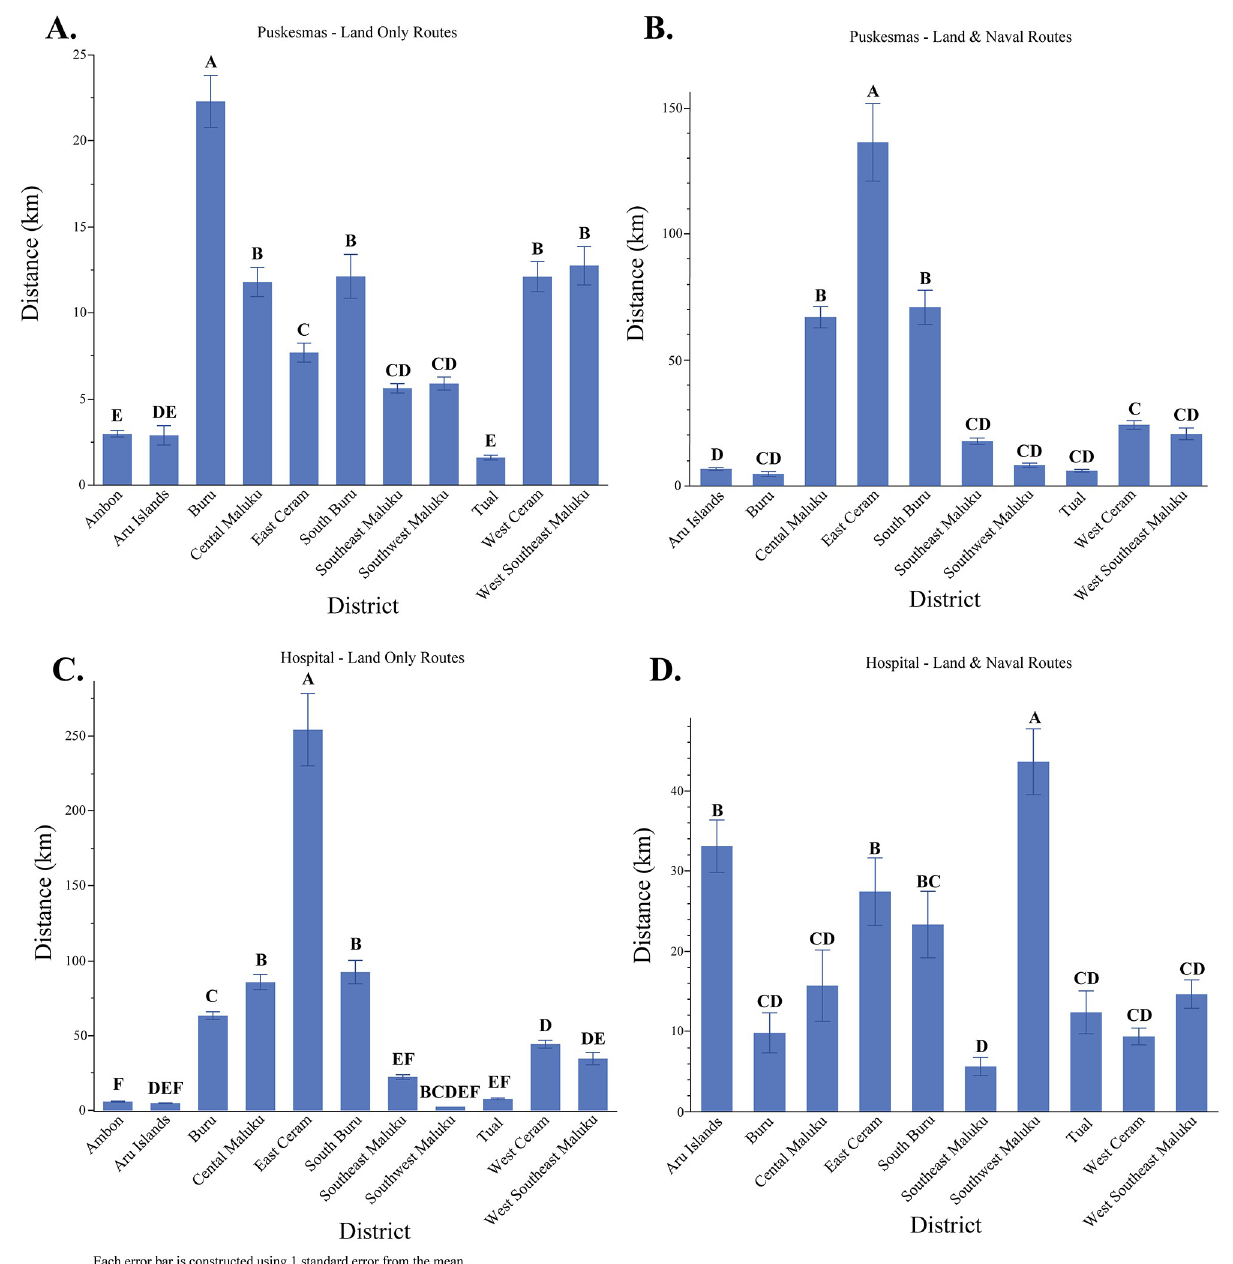
Fig 3. Total mean distance length (km) by healthcare facility (hospital and puskesmas) and route type (land and naval routes). Within-group statistical comparisons were conducted by using Student’s t-test; unique letters indicate significantly different mean values ( p < 0.05).